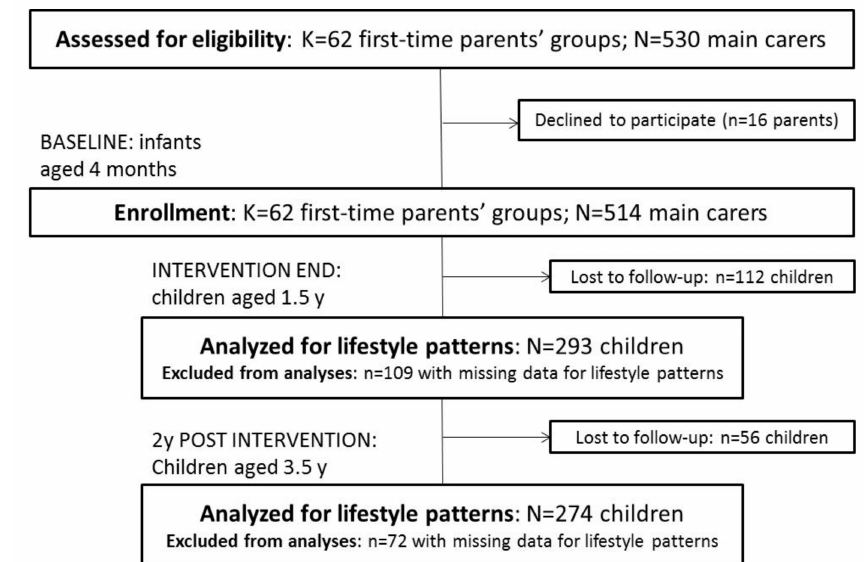
Figure 2. Flow of participants through the Melbourne InFANT Extend